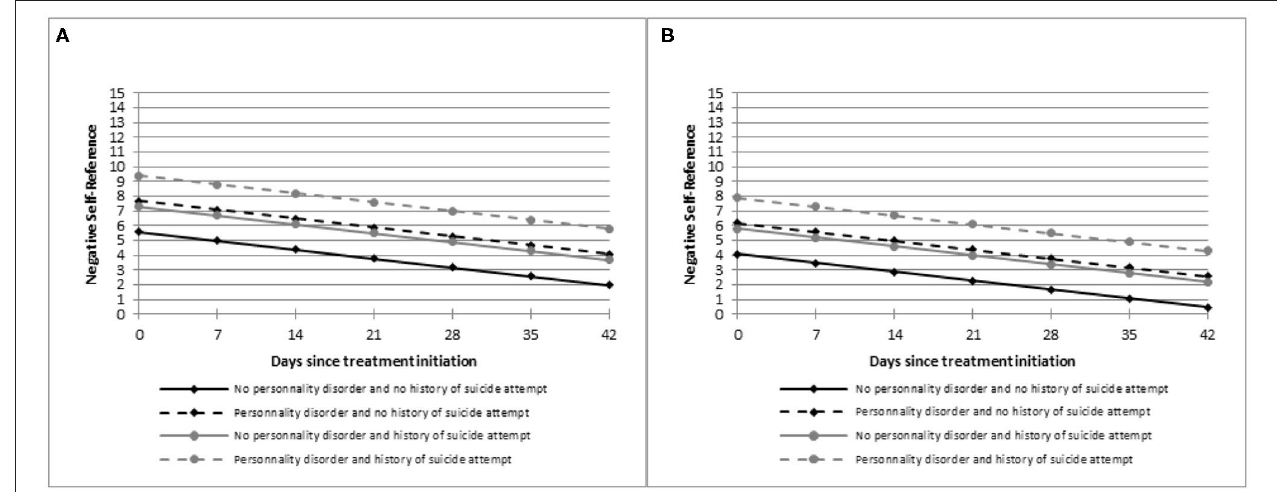
FIGURE 1 | Estimated means of negative self-reference scores over time according to age, personality disorders, and history of suicide attempts. Only means for women (reference category of the linear mixed model) are represented. (A) patients under 65 years. (B) patients aged 65 years or older.